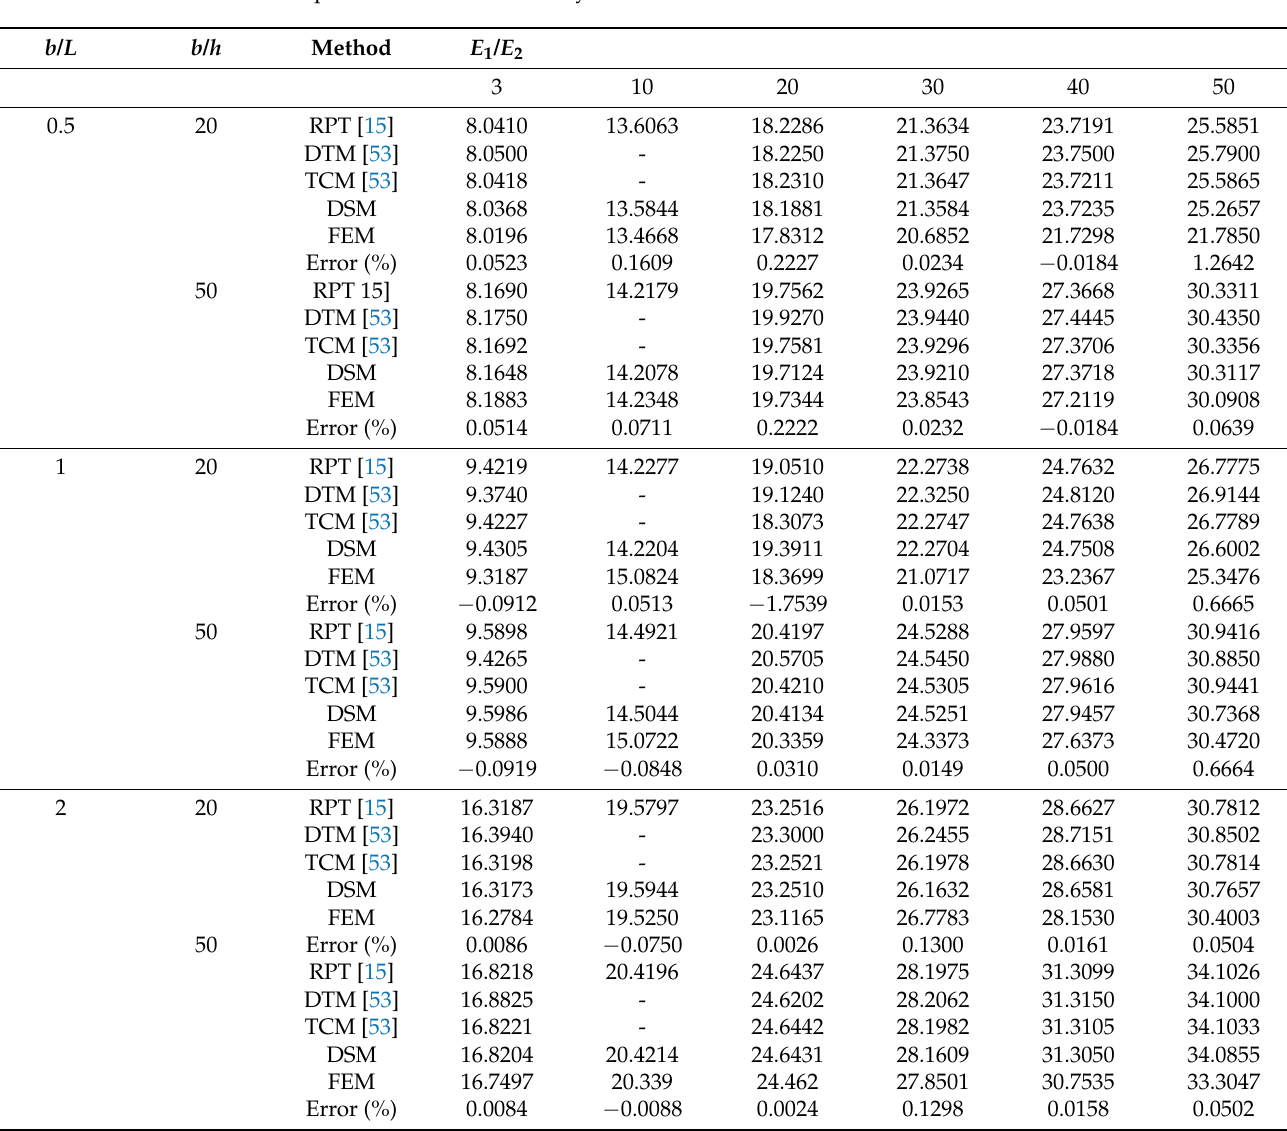
Table 3. Comparison of the fundamental frequency parameters plate with the SC boundary